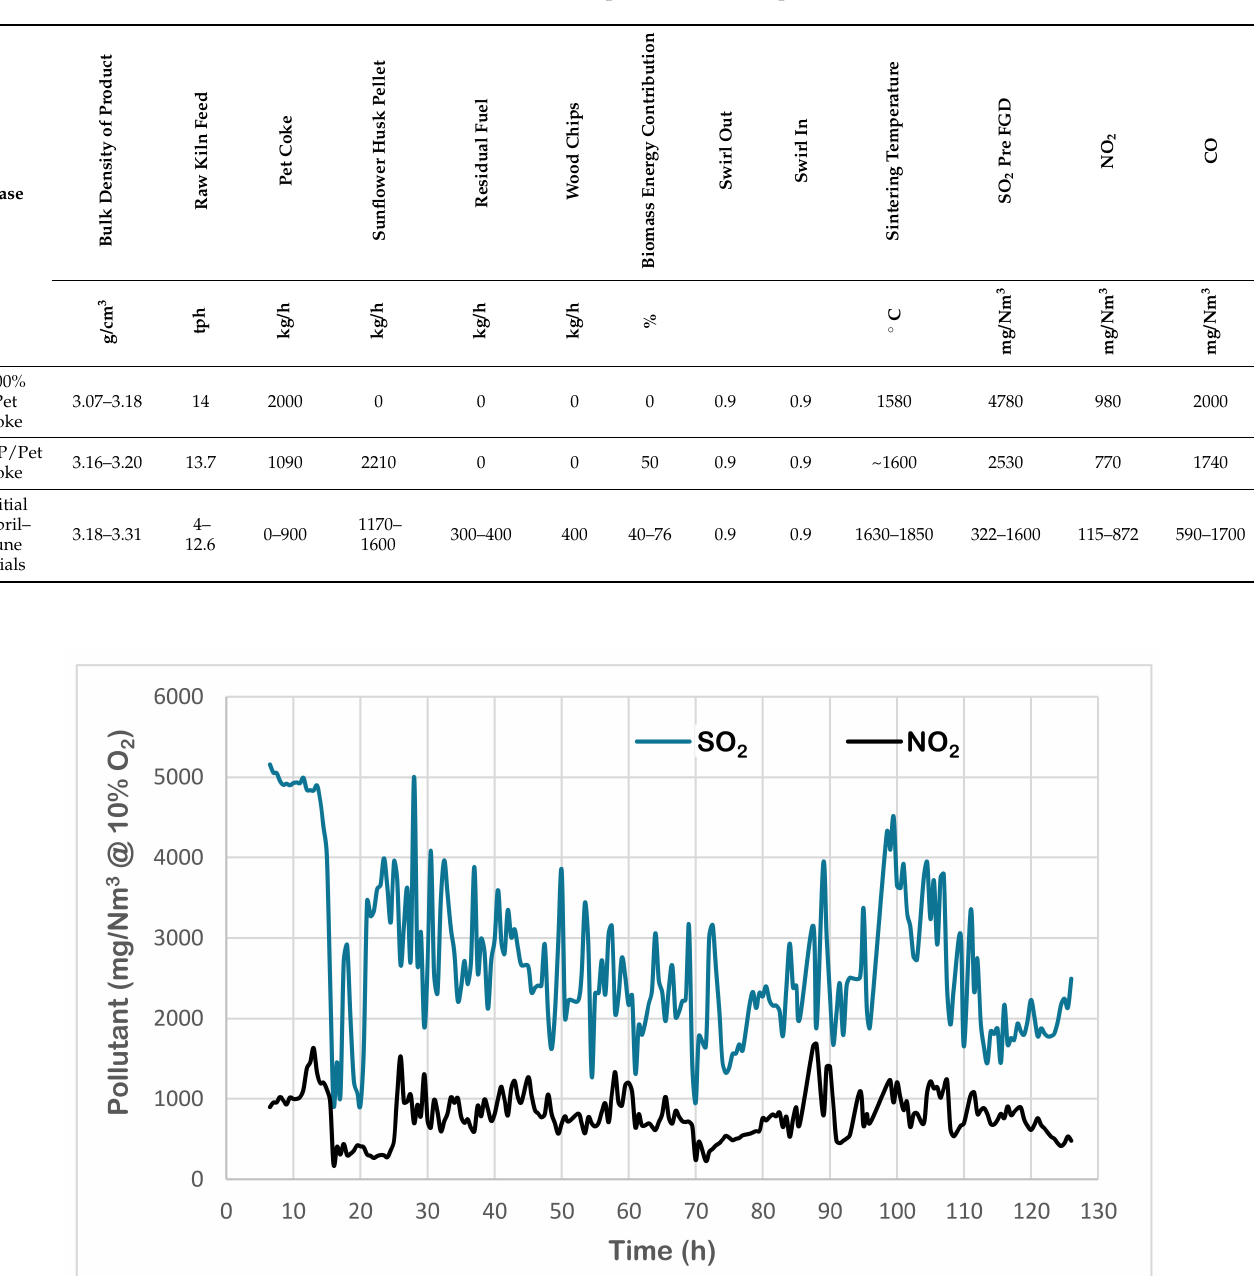
Table 6. Fuel mix main trail compared with 100% pet-coke.